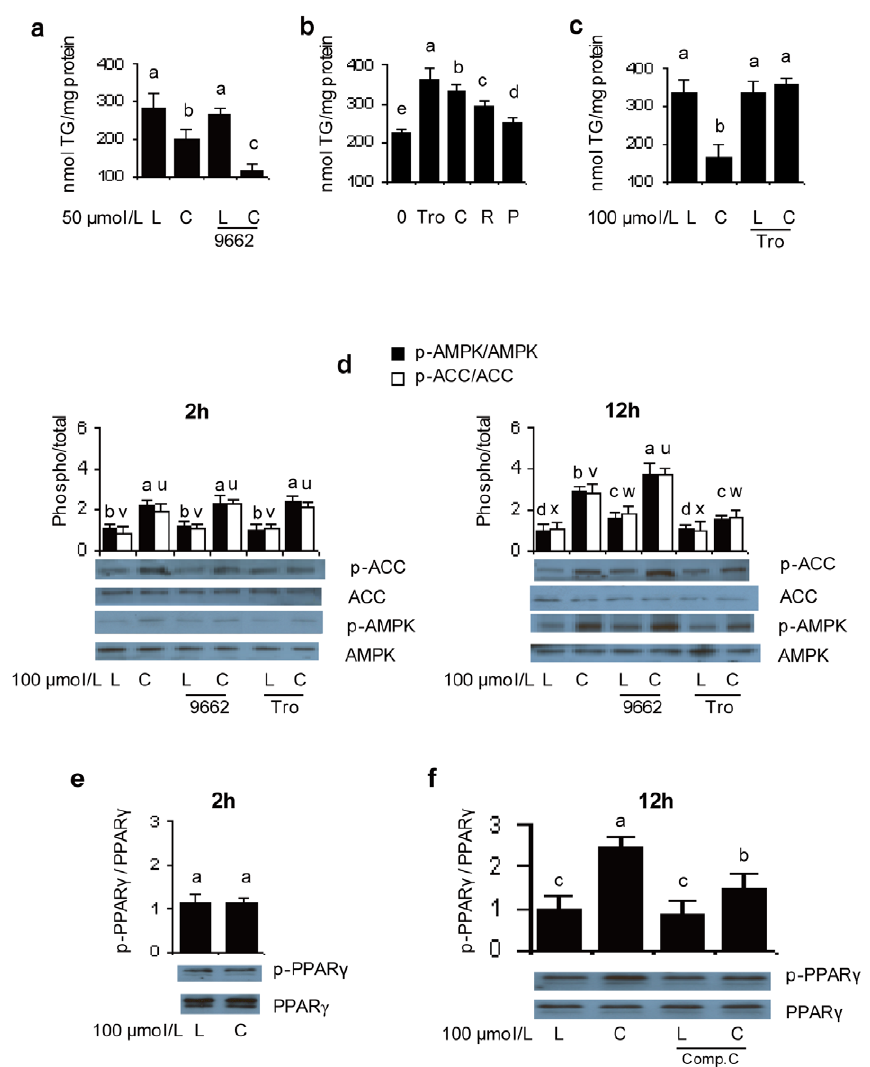
Figure 4. PPAR c antagonists and agonists affect TG levels and modulate p-AMPK activity levels in t 10 c 12 CLA treated 3T3-L1 adipocytes. a Differentiated adipocytes were incubated with 50 m mol/L LA (L) or t 10 c 12 CLA (C) with or without PPAR c antagonist GW9662 (9662) for 24 h and TG levels were measured. b Differentiating adipocytes were treated with either control media (0), troglitazone (Tro), ciglitazone (C), rosiglitazone (R), or pioglitazone (P) to determine which PPAR c agonist was most effective for increasing TG levels. c Differentiated 3T3-L1 adipocytes were incubated with 100 m mol/L LA or t 10 c 12 CLA, with or without PPAR c agonist troglitazone (Tro), and TG levels were measured after 24 h. d Adipocytes were treated as in a or c for 2 or 12 h using 100 m mol/L LA or t 10 c 12 CLA, and representative western blots of cytosolic extracts indicate the proteins detected with antibodies to p-ACC (p-Ser79), total ACC, p-AMPK (p-Thr172), or total AMPK. The ratio of the phosphorylated to total form of each protein (phospho/total) is shown in the bar graphs. e–f The amount of phosphorylated or total PPAR c in nuclear extracts was measured after 2 or 12 h of treatment with 100 m mol/L LA or t 10 c 12 CLA, and with or without compound C (Comp. C) at 12 h. The ratio of the amount of phosphorylated to total PPAR c is shown in the bar graphs. Each bar in panels a–f represents the mean + SEM (n=3), and is representative of three independent experiments ( a–c ) or is the mean of three independent experiments ( d–f ). Means within each data type (a–e or u–x) not sharing a common letter differ, P ƒ